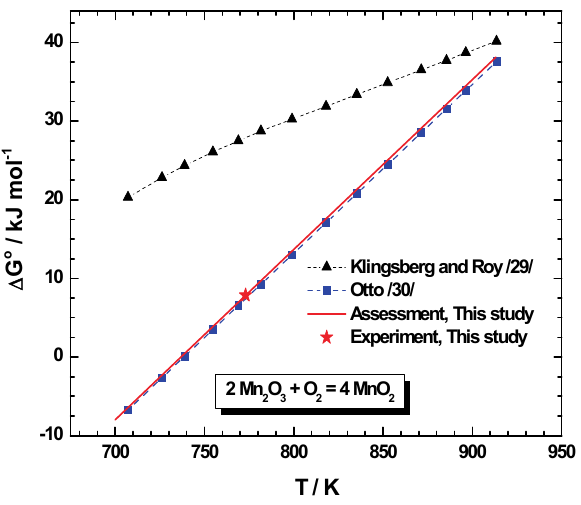
Figure 10. Comparison of Gibbs energy change for the oxidation of Mn 2 O 3 to MnO 2 reported by Klingsberg and Roy [29], and Otto [30] with the result obtained this study.